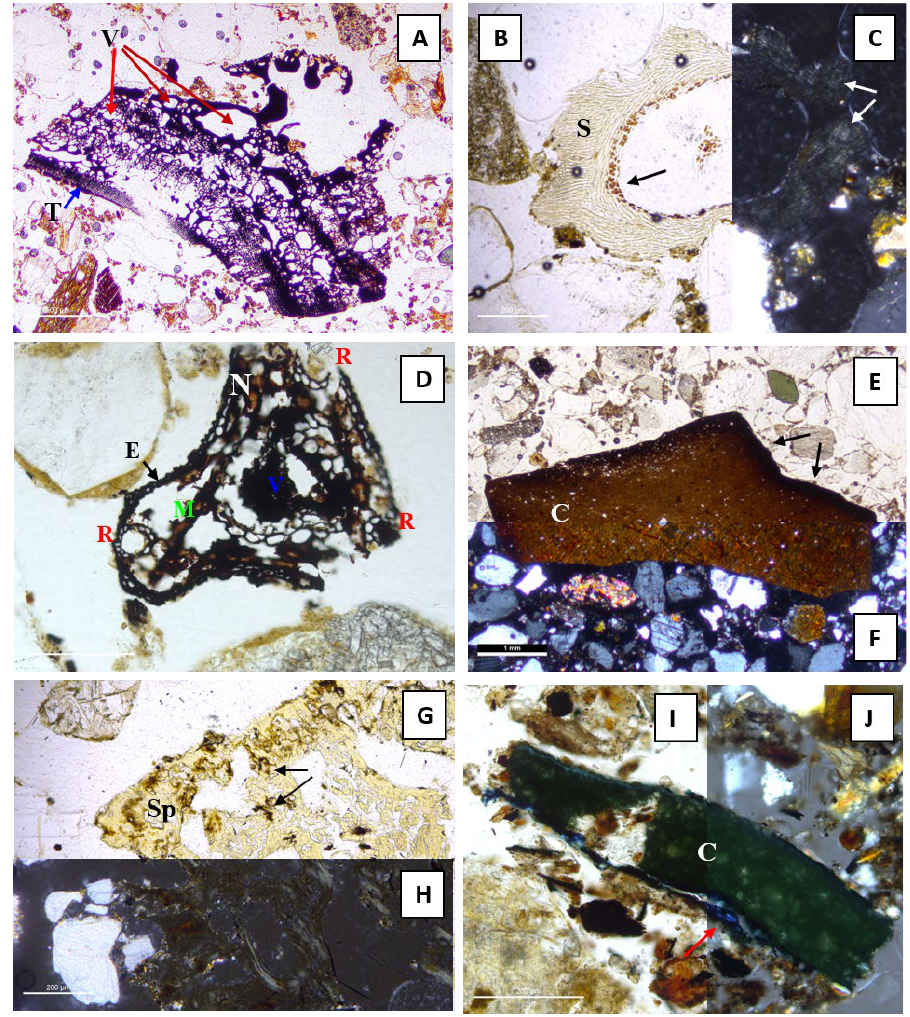
Figure 9. Anthropogenic elements found in the archaeological pit features at the Fort Odanak site (CaFe-7). ( A ) Transverse section of a charcoal fragment from a coniferous wood species. One-year ring with parallel rows of tracheids (T) can be observed, as well as a possible portion of the inner bark. Note the vesicles (V) formed during carbonization (Pit feature 12A57, ⁓ 55 cm/surface, PPL). ( B ) Cross-section of a Rubus seed (S). Only the seed coat is preserved. Traces of bacterial action (black arrow) are visible on the inside of the fragment (Pit feature 12A57, ⁓ 55 cm/surface, PPL). ( C ) Same in XPL. Stone cells in the endocarp show a weak interference (white arrows). ( D ) Transverse section of a partially decomposed conifer needle (N). The outer epidermis (E) and three resin ducts (R) can be identified clearly, and some parts of the central vascular bundle (V) are still visible. The spongy mesophyll (M) is mostly decayed (Pit feature 12A72, ⁓ 60 cm/surface, PPL). ( E ) Angular ceramic fragment (C) made of fine brownish clayey material with quartz grains visible in the matrix. The outer edge of the sherd is slightly burnt (arrows) (Pit feature 12F50C, ⁓ 33 cm/surface, PPL). ( F ) Same in XPL. The fragment shows a strong birefringence with a parallel striated b-fabric. ( G ) Spongy bone fragment (Sp) with visible pores and traces of bacterial activity (arrows). (Pit feature 12F50C, ⁓ 33 cm/surface, PPL). ( H ) Same in XPL. The fragment exhibits low-order greyish interference colors typical of bone materials. The fragment is slightly oxidized in areas where bacterial presence is the strongest. ( I ) Green ceramic fragment (C) with blue glazing (arrow) on its outside. Small mineral grains are detectable in the matrix. The sherd is partially coated in organic plasma (Pit feature 12A64, ⁓ 58 cm/surface, PPL). ( J ) Same in XPL. No change in color can be observed in the matrix. PPL, polarized microscope in plane-polarized light; XPL, crossed polarized light.